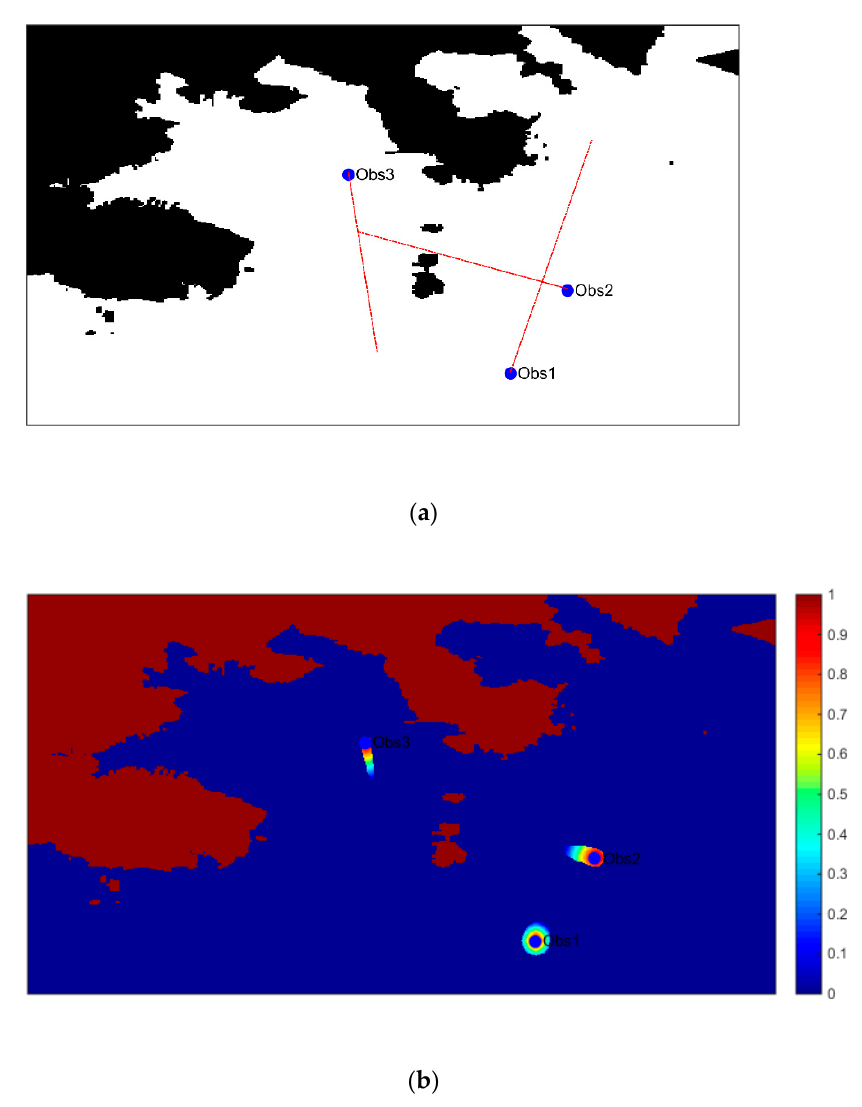
Figure 14. Dynamic modeling: ( a ) dynamic obstacles information; ( b ) dynamic obstacle field M dynamic .